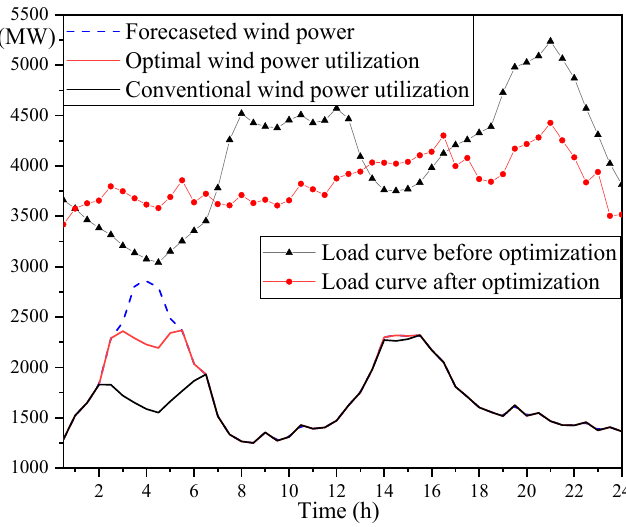
Figure 5. System load and wind power utilization.